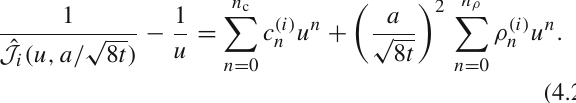
tion of the data can be obtained by using a simple linear